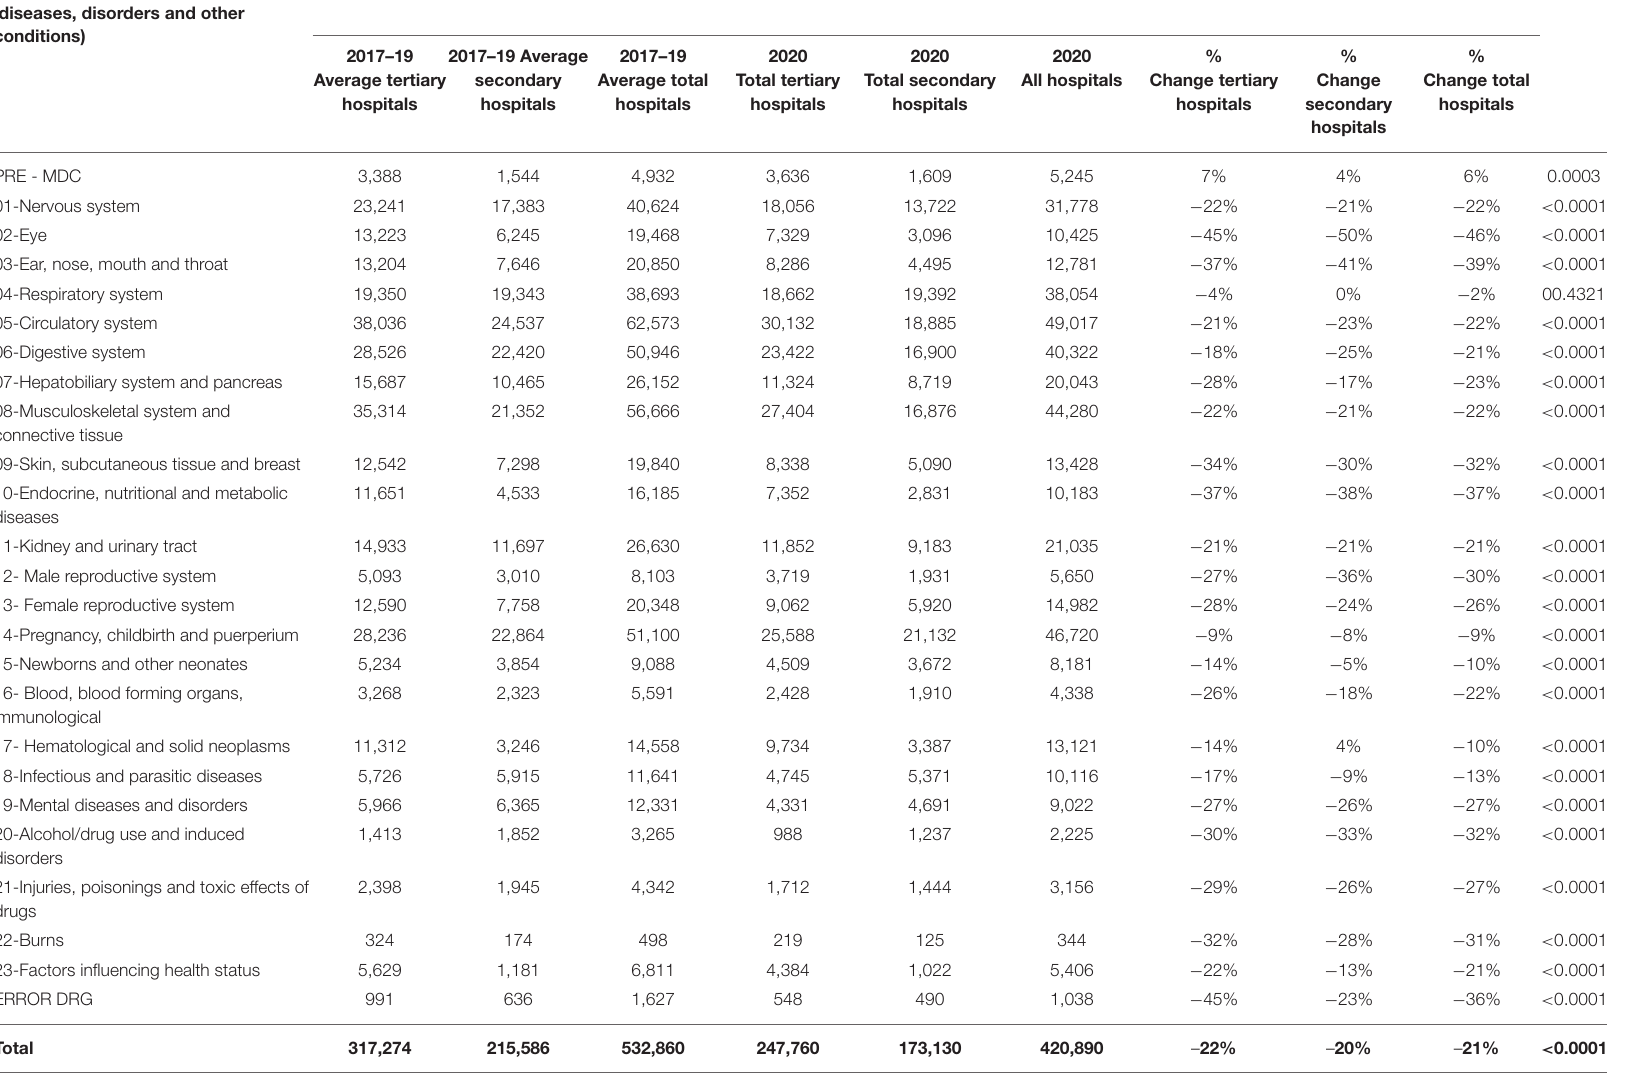
TABLE 1 | Comparison of DRG case activity before, and during Covid 19 in 2020. Major diagnostic categories (diseases, disorders and other